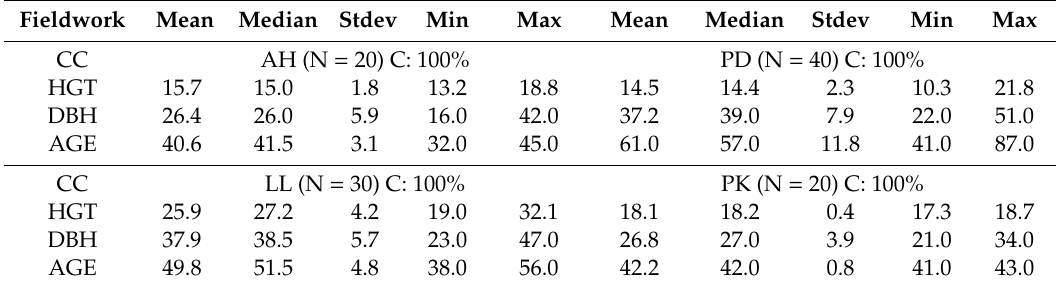
Table 6. Descriptive statistics of field measurements of forest